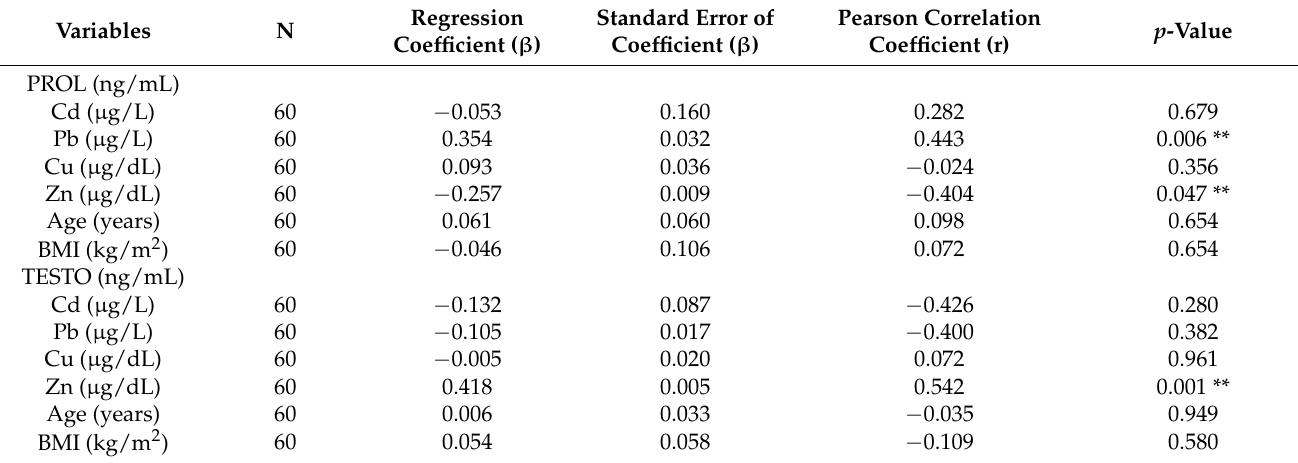
Table 9. Interrelationship of sex hormones with other measured